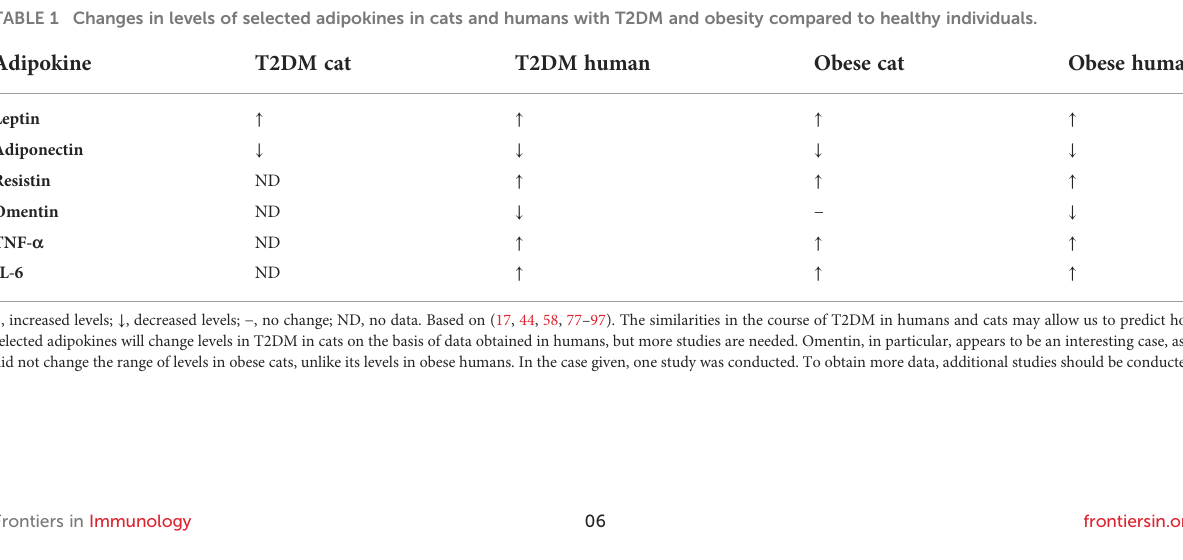
TABLE 1 Changes in levels of selected adipokines in cats and humans with T2DM and obesity compared to healthy individuals. Adipokine Obese cat Obese human Leptin ↑